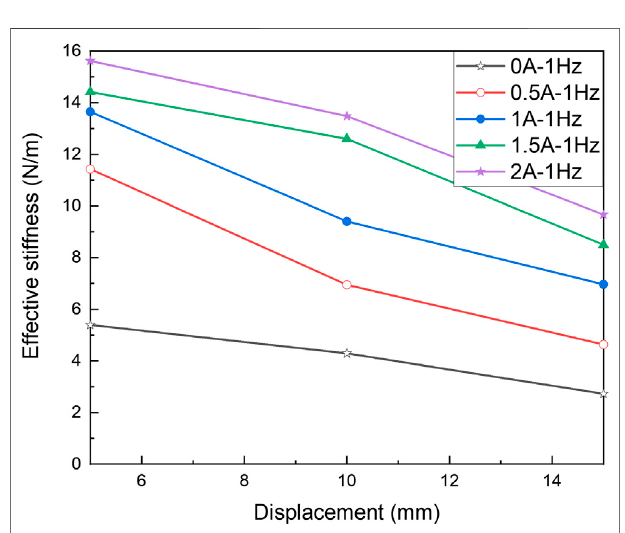
FIGURE 9 | The effective stiffness of the MR seat suspension under different excitation amplitudes.